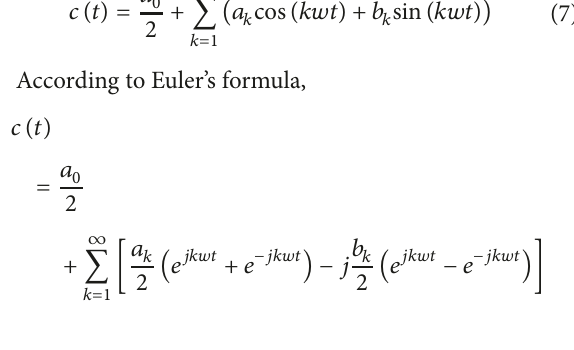
Figure 8: A continuous